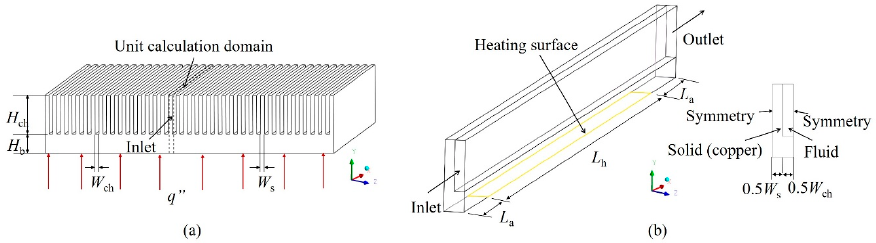
Figure 1. ( a ) Schematic of rectangular microchannel heat sink ( b ) Simulation domain and boundary conditions.